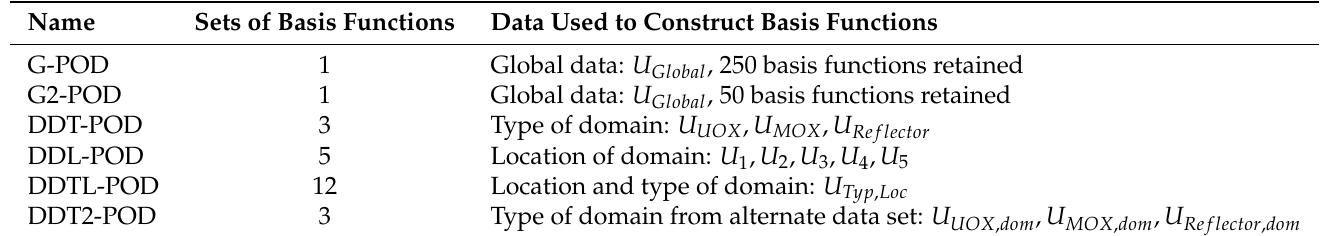
Table 3. Table showing the six methods, how many sets of basis functions are retained and the data from which they are constructed. POD, Proper Orthogonal